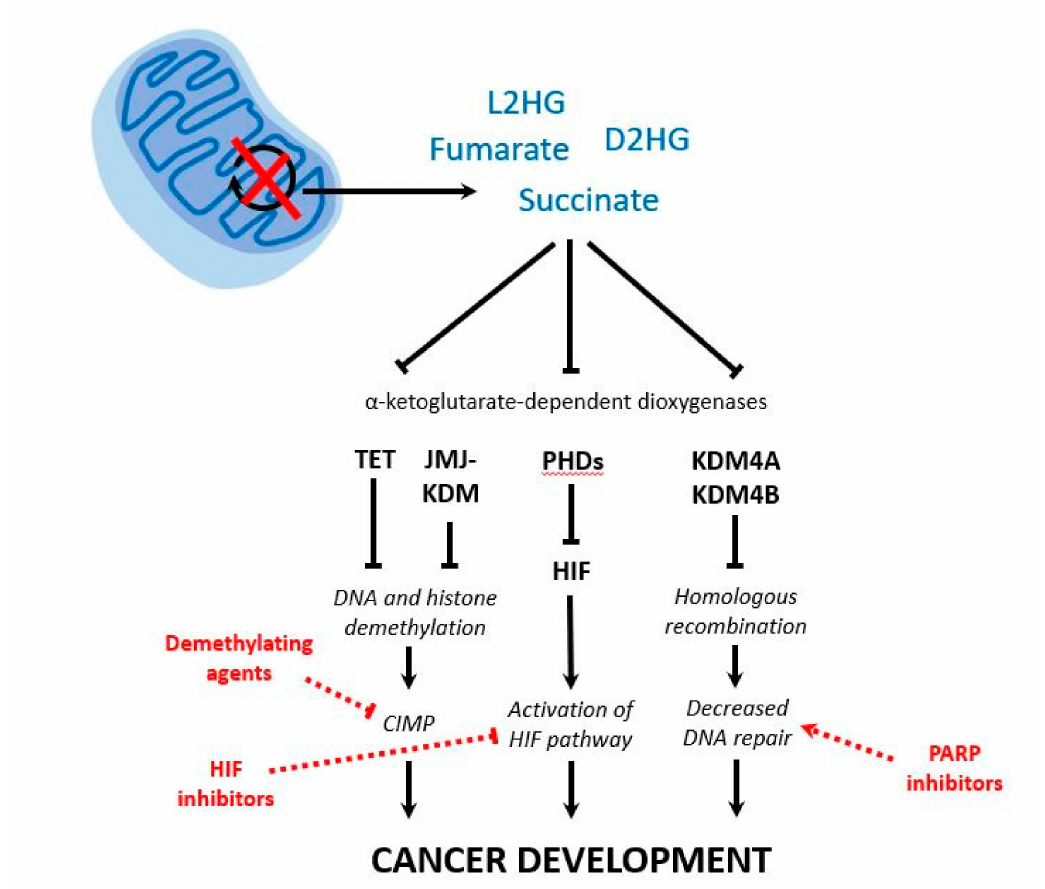
Figure 2. Schematic representation of the consequences of tricarboxylic acid (TCA) cycle disruption in pheochromocytomas and paragangliomas (PPGL). Upon disruption of the activity of pivotal TCA cycle enzymes, there is an accumulation of metabolites (i.e., succinate, fumarate, D2HG and L2HG). Their e ffl ux from the mitochondria to the cytosol and their subsequent competition with α -ketoglutarate lead to the inhibition of α -ketoglutarate-dependent dioxygenases involved in DNA and histone demethylation, regulation of HIF, and homologous recombination. As a result, di ff erent mechanisms are proposed as the cause of tumorigenesis in PPGL: aberrant global hypermethylation (CIMP), activation of the HIF pathway and decreased DNA repair. Finally, di ff erent therapeutic options may target each altered pathway: demethylating agents, HIF inhibitors, and poly-(ADP-ribose)-polymerase (PARP) inhibitors, respectively. D2HG: D-2-hydroxyglutarate; L2HG: L-2-hydroxyglutarate; TET: ten-eleven translocation DNA hydroxylase; JMJ: Jumonji; KDM: histone lysine demethylase; PHDs: prolyl hydroxylase domain-containing proteins; HIF: hypoxia-inducible factor; CIMP: CpG island methylation